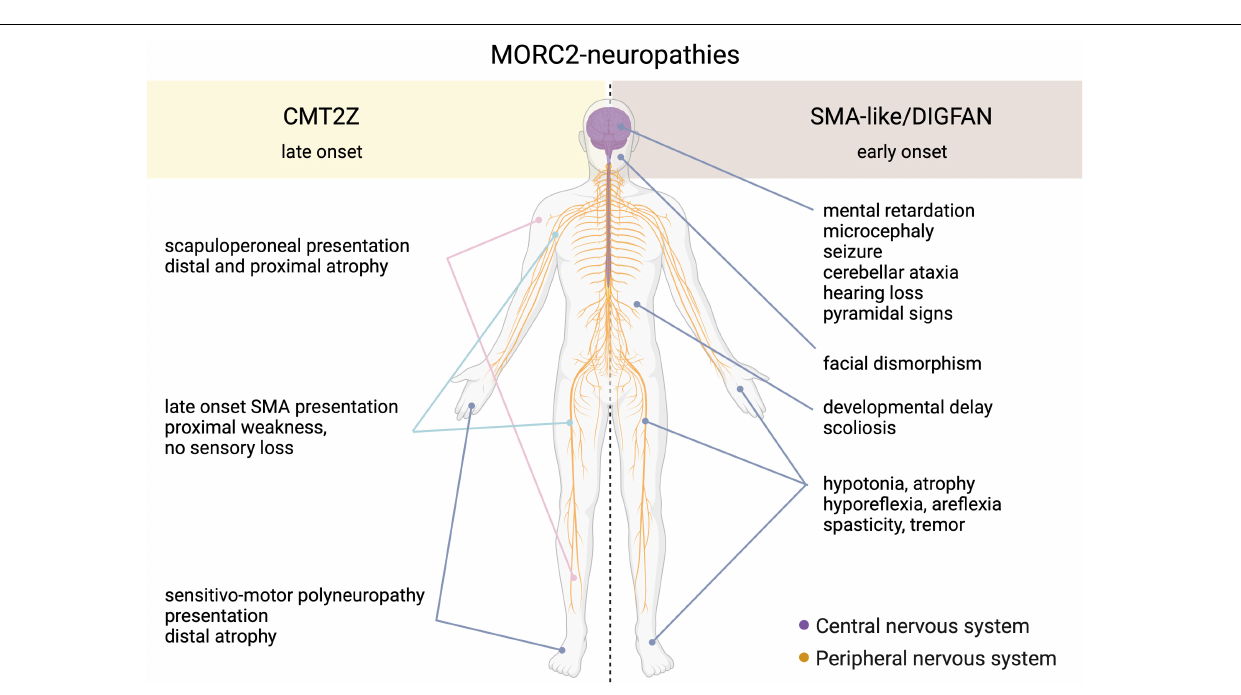
(Semplicini et al., 2017), p.Q400R (Ando et al., 2017),